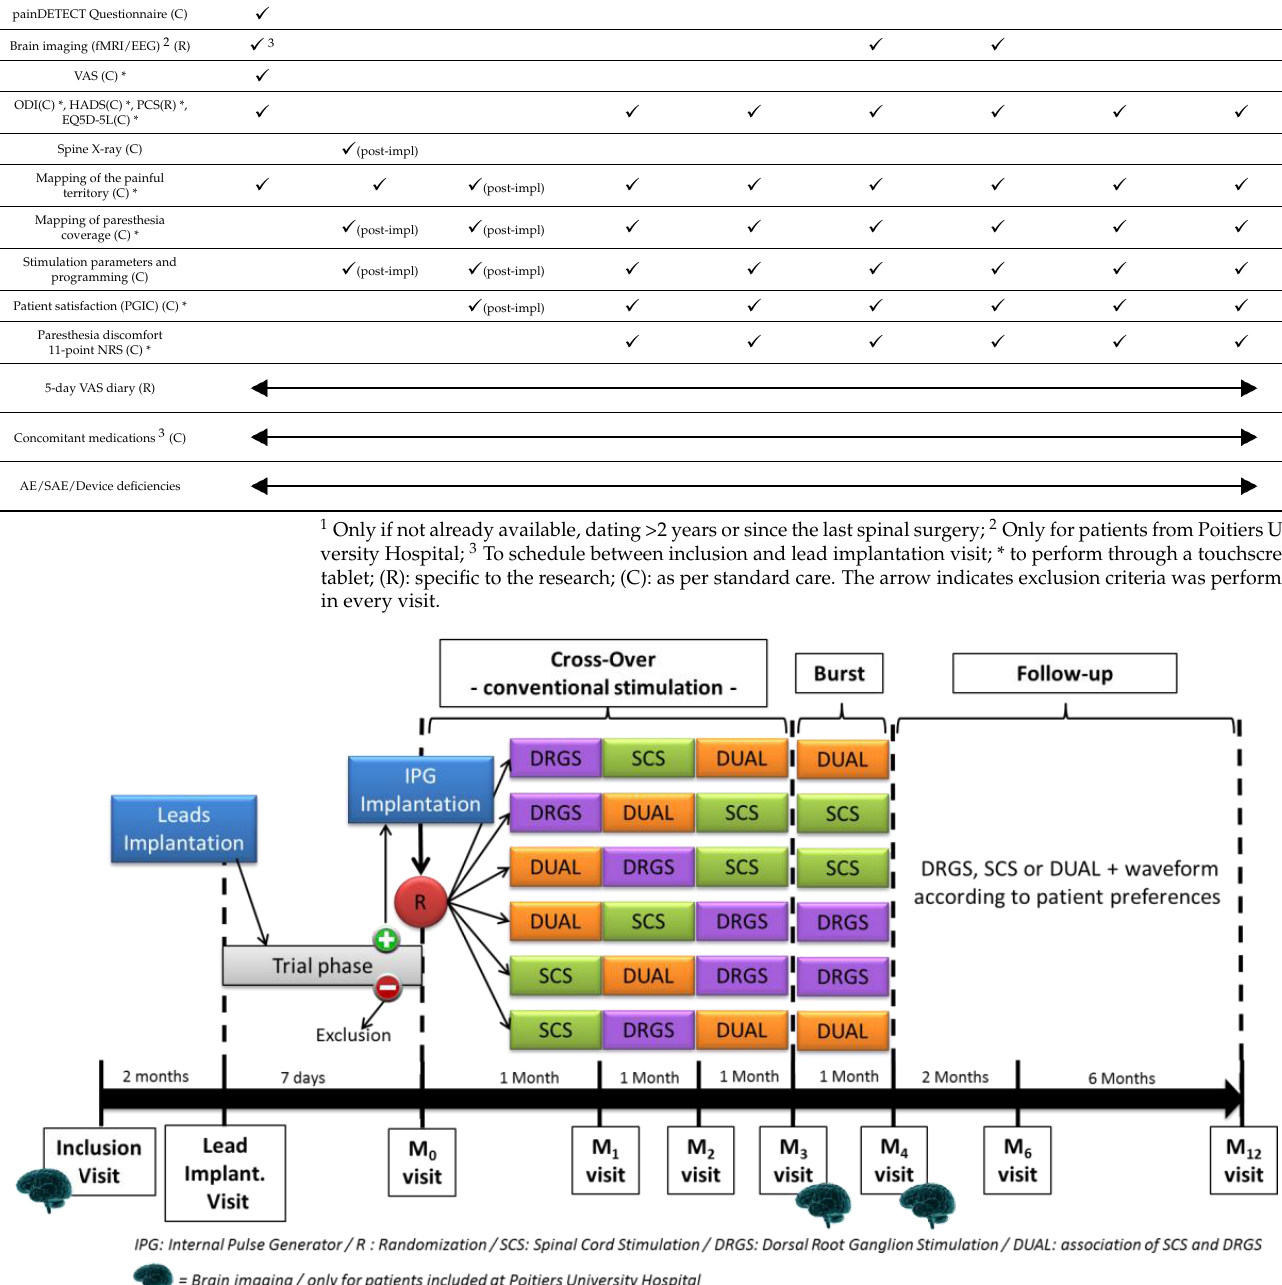
Figure 1. BOOST DRG study design (applicable for phase A and phase B). Table 1. Radio-clinical assessment calendar.